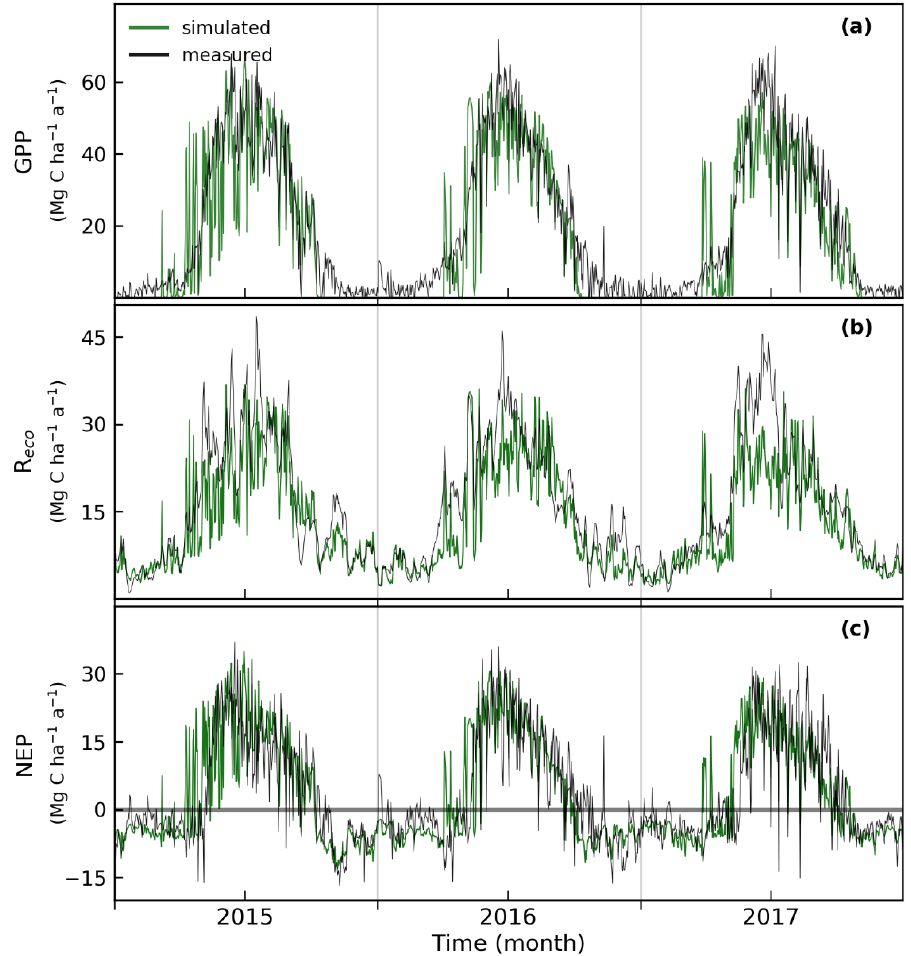
Figure 2. Daily simulated and measured carbon fluxes for the years 2015–2017 at the forest Hohes Holz (DE-HoH). The observed data as black lines, simulated carbon fluxes as green line for ( a ) GPP ( b ) R eco and ( c ) NEP . Measured temperature, the simulated and measured soil water content, and the photon flux density are in the Appendix A (see Figure A1). For 1:1 plot see Figure A2 in the Appendix C.